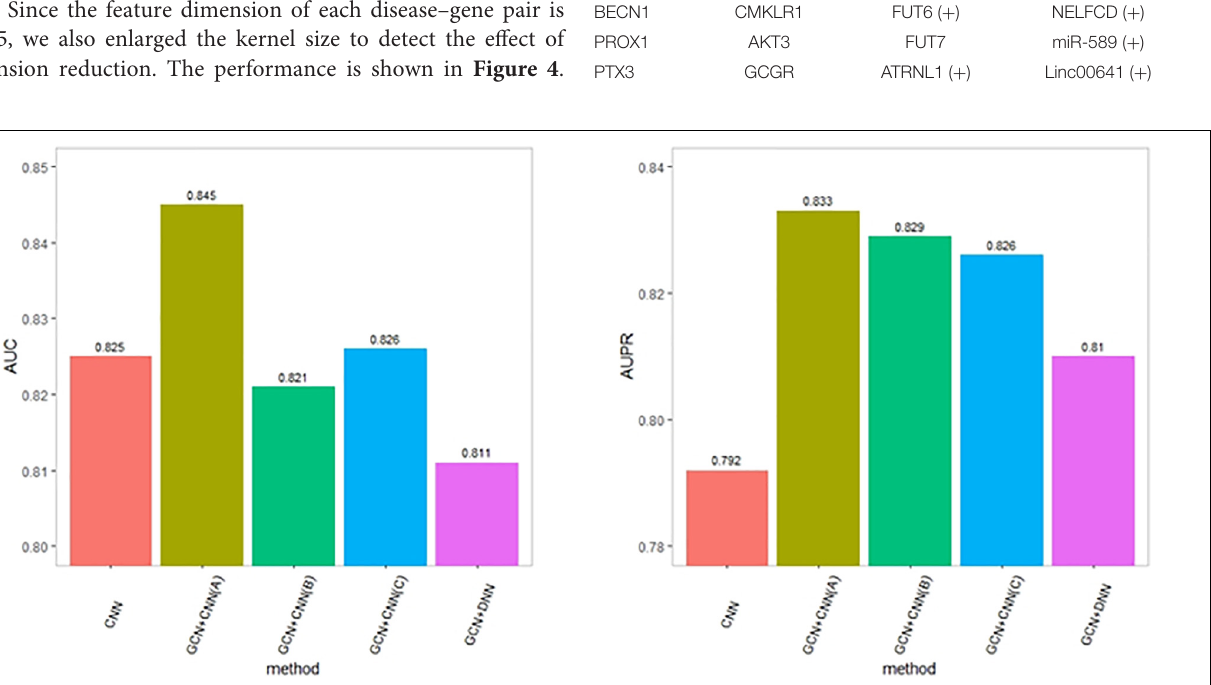
FIGURE 4 | Performance comparison with variational deep learning